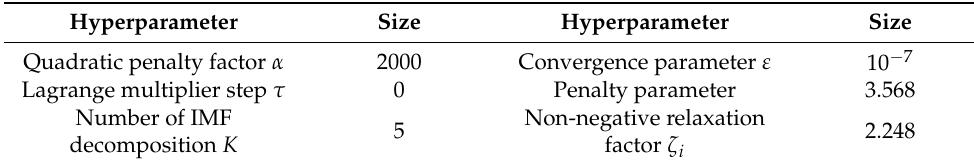
Table 2. The VMD-Volterra-SVM algorithm